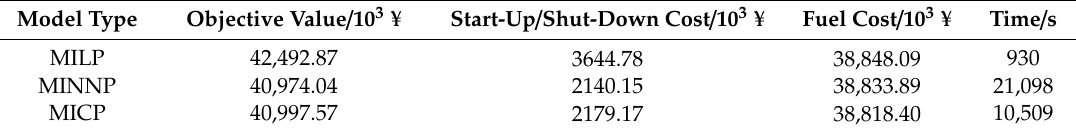
Table 12. Comparison of results computed by three SCUC models.